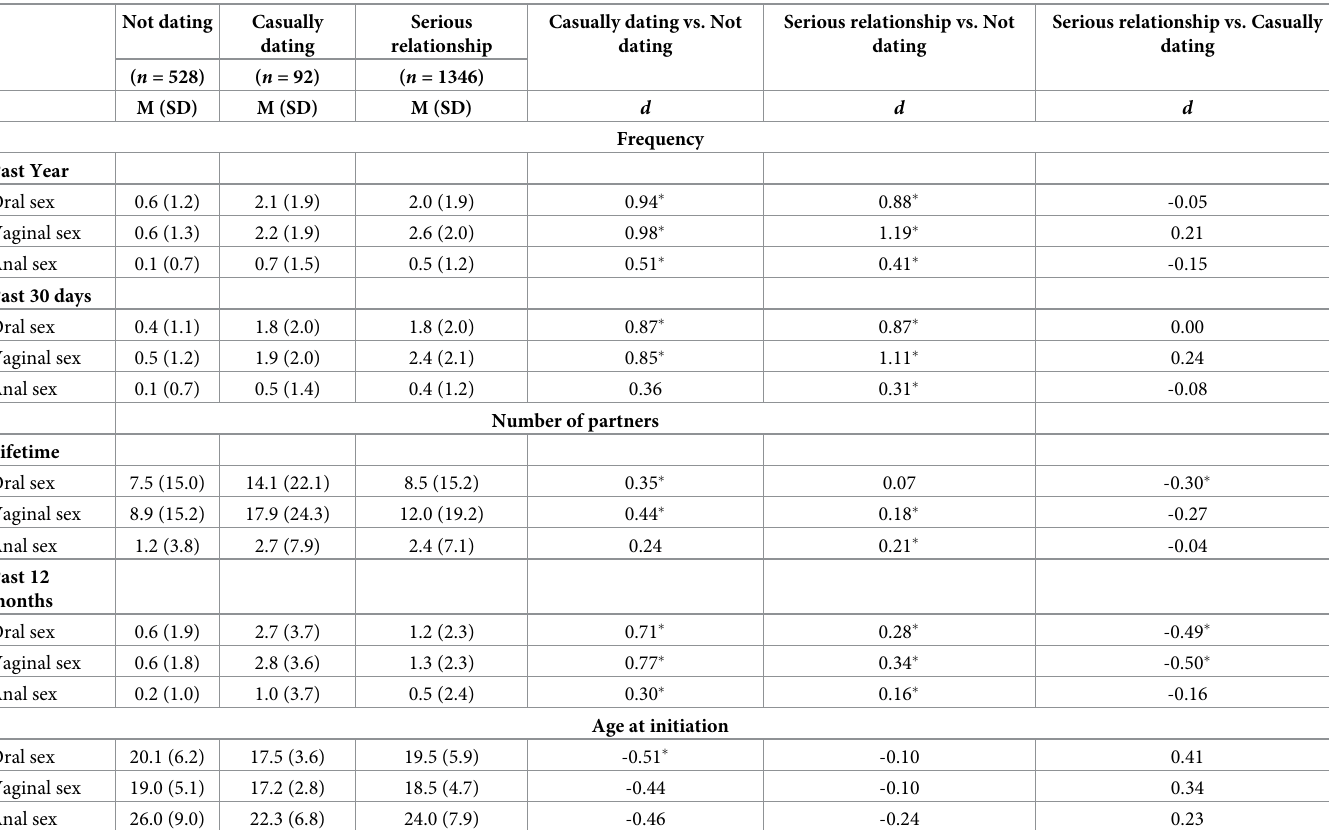
Table 6. Descriptive statistics and comparisons across relationship status for frequency, number of partners, and age of initiation of oral, vaginal, and anal sex. Not